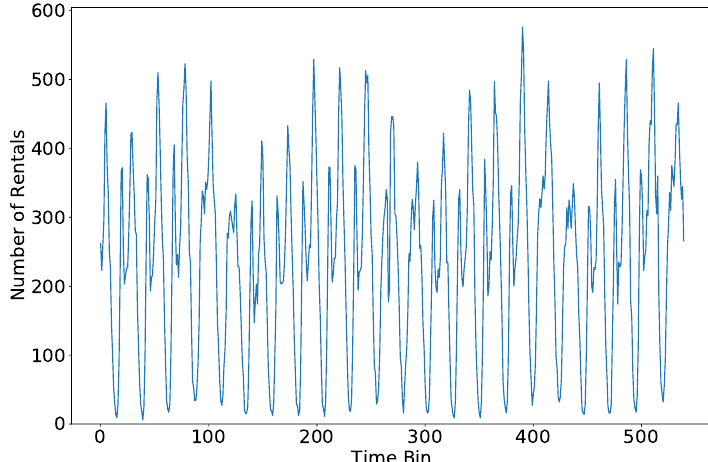
Figure 1. Time series of starting rentals in September 2017 aggregated per hour. The difference in the total number of time bins and the actual number of hours in the month are due to missing data (crawler